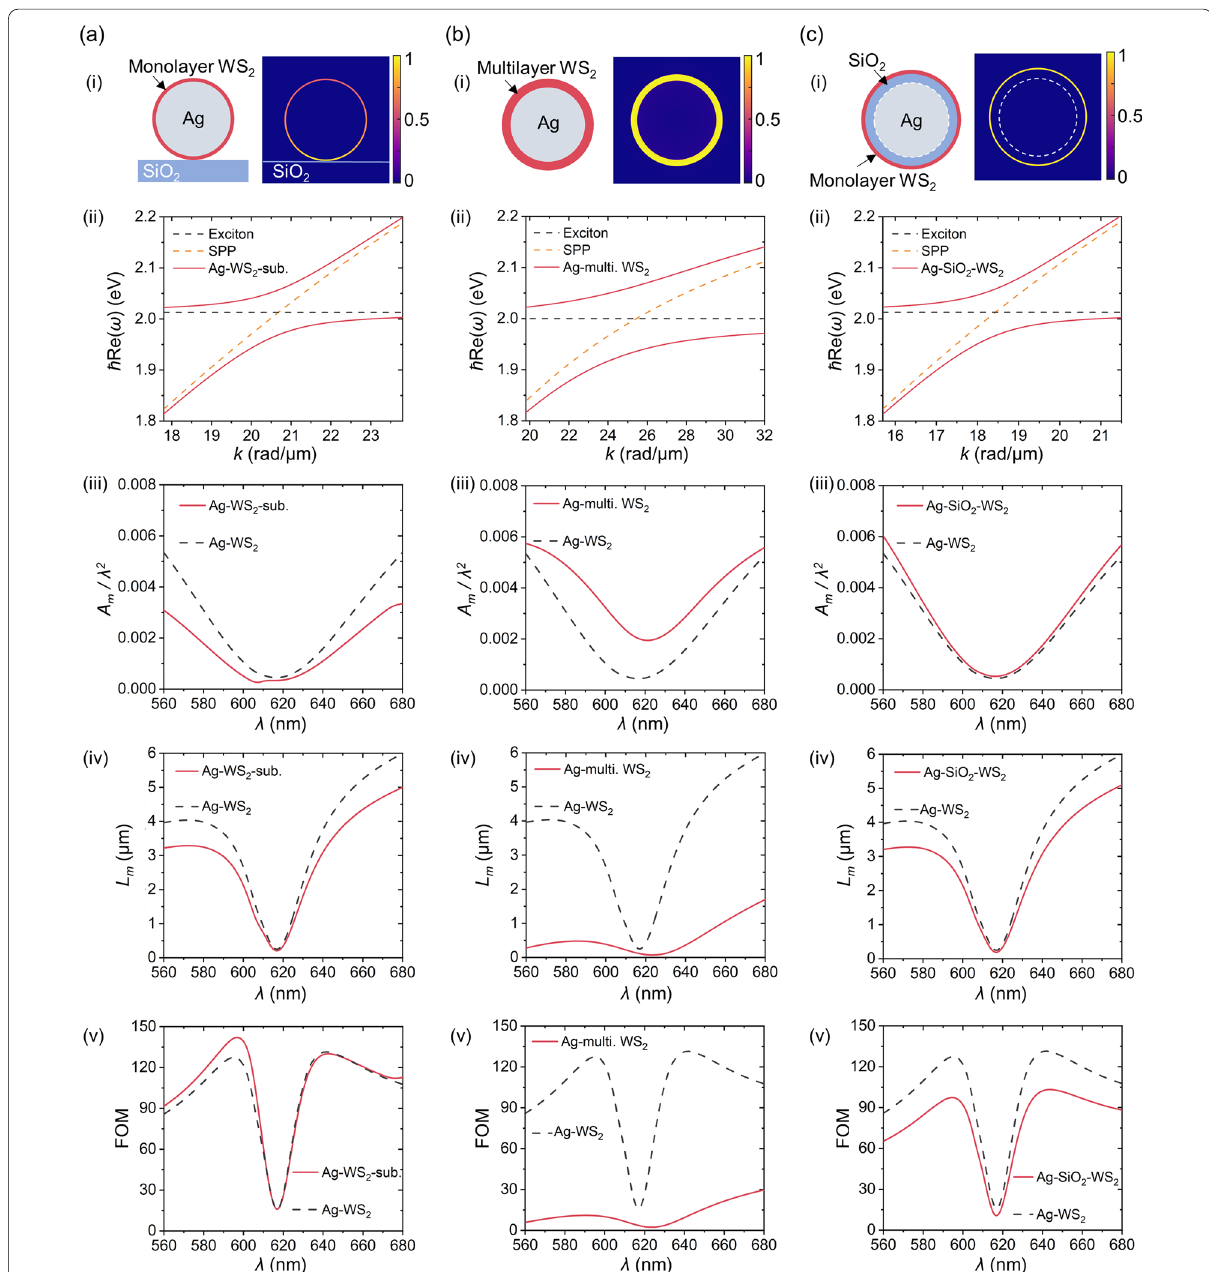
2 -clad MNW with a silica insulating layer (Ag-SiO 2 -WS 2 ). ( i ) Schematic plot (left) and mode profile at the excitonic resonance (right). ( ii ) Rabi splitting dispersion of the corresponding PEPPs (red lines). Yellow and black dashed lines: SPPs and excitons. ( iii ) Normalized mode area A m / λ 2 . ( iv